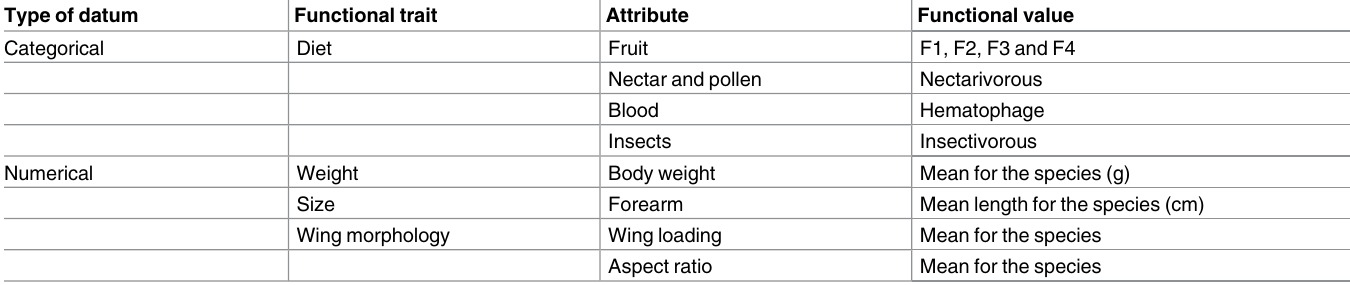
Table 2. Functional traits used to determine the functional diversity of the bat community in the Huastecaregion of the state of Hidalgo, Mexico. Functional groups of the frugivorous species (S1 Fig): F1: Sturnira hondurensis and S . parvidens , F2: Artibeuslituratus and A . jamaicensis , F3: